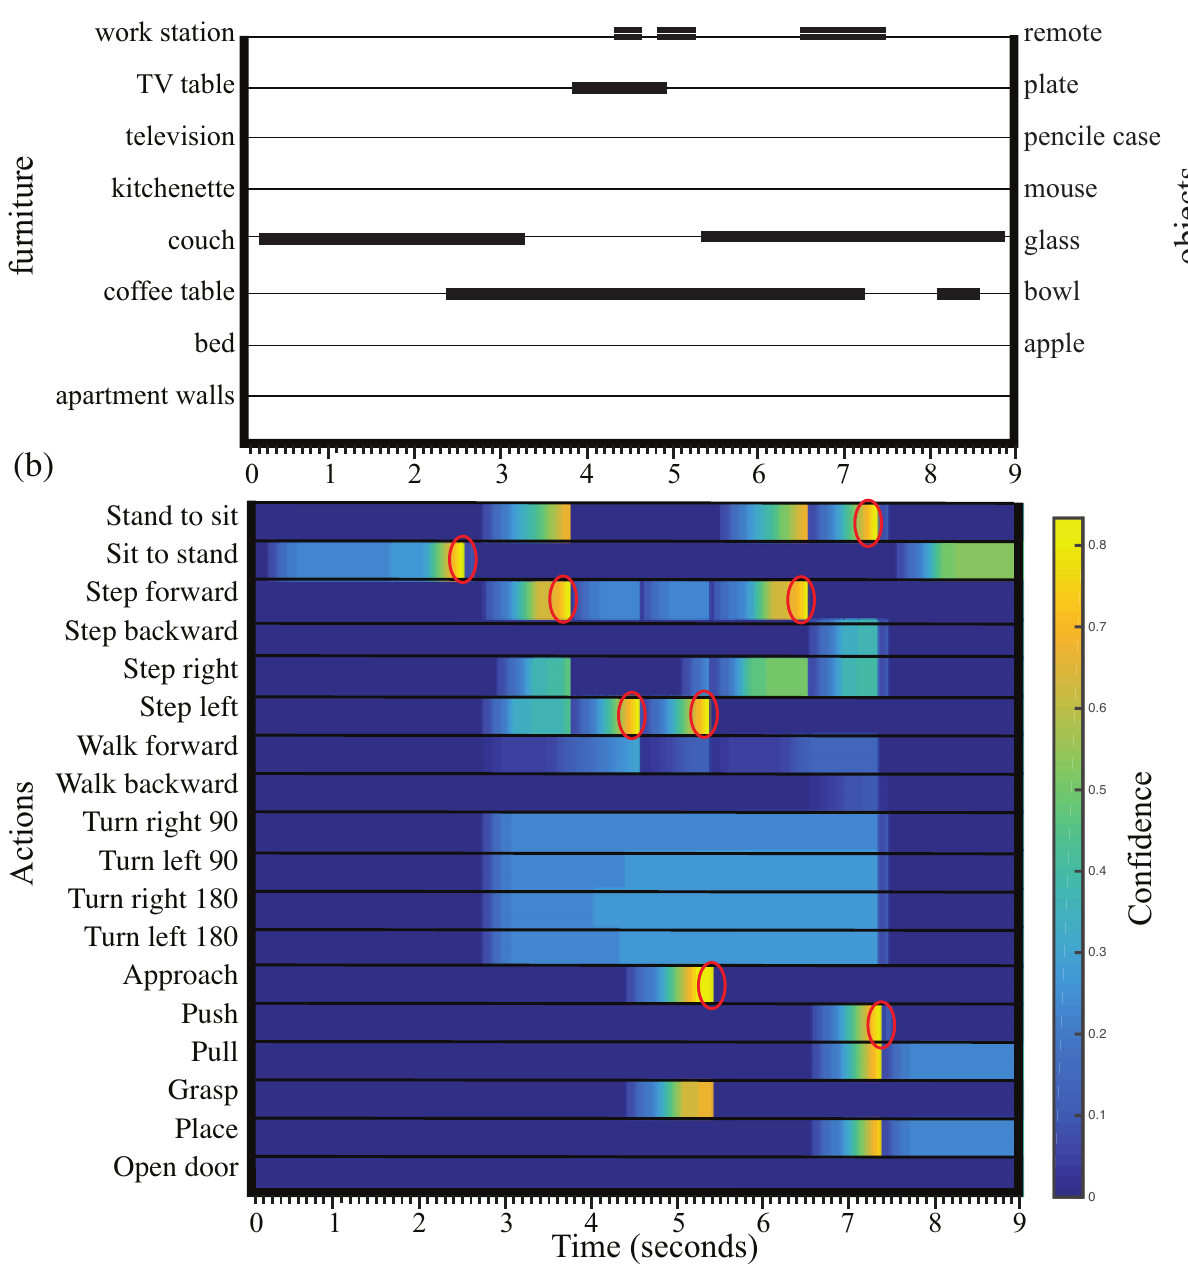
Figure 19. Results for the “pick up remote” scenario (a) Results of the CARS indicating the interaction of the right wrist with the furniture (left, solid lines) and objects (right, solid dashed lines). This indicates that there was interaction with the couch at the beginning and the end of the complete action, with interactions with the coffee table and the TV table in the middle of the complete action. (b) Results of the TARS. Many TARMs are online and comparing the observed movement dynamically, once one of the systems in competition achieves an accuracy of over 0.8, then all systems are reset and wait for CARS to bias the next round of comparisons. The red ovals indicate a decision